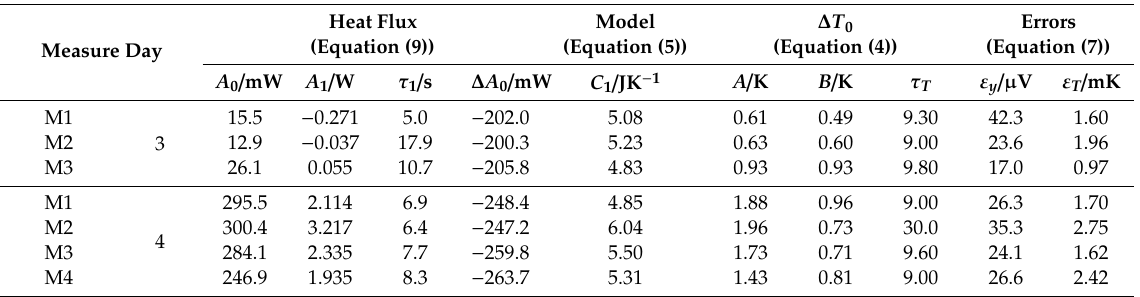
Table 6. Results of measurements made on the right hand in the senior subject in two di ff erent days (day 1: T room = 21.3 ◦ C, day 2: T room = 21.8 ◦